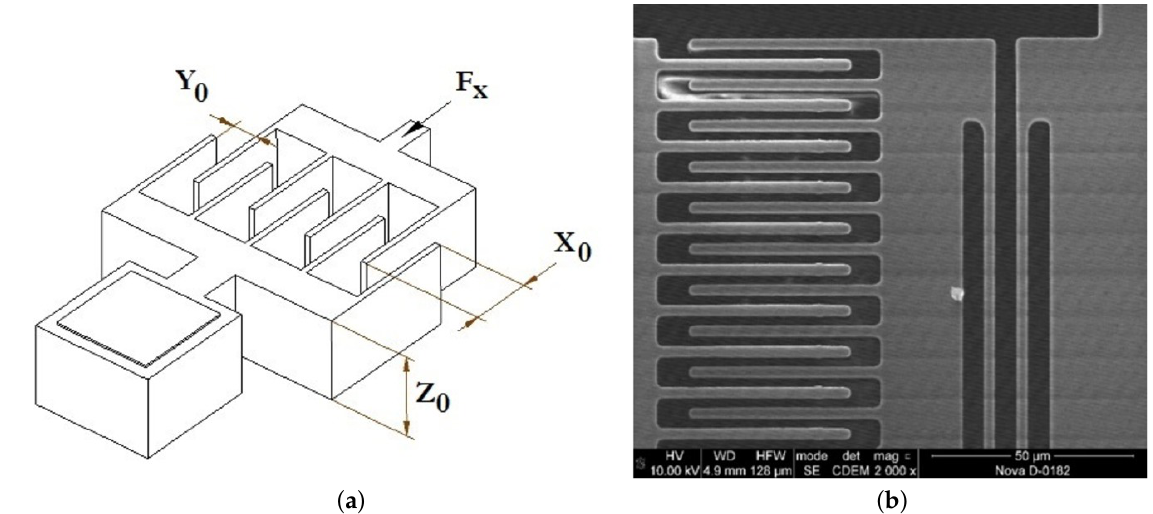
Figure 8. Electrostatic comb counter-pin actuator: ( a ) schematic view; ( b ) SEM image.